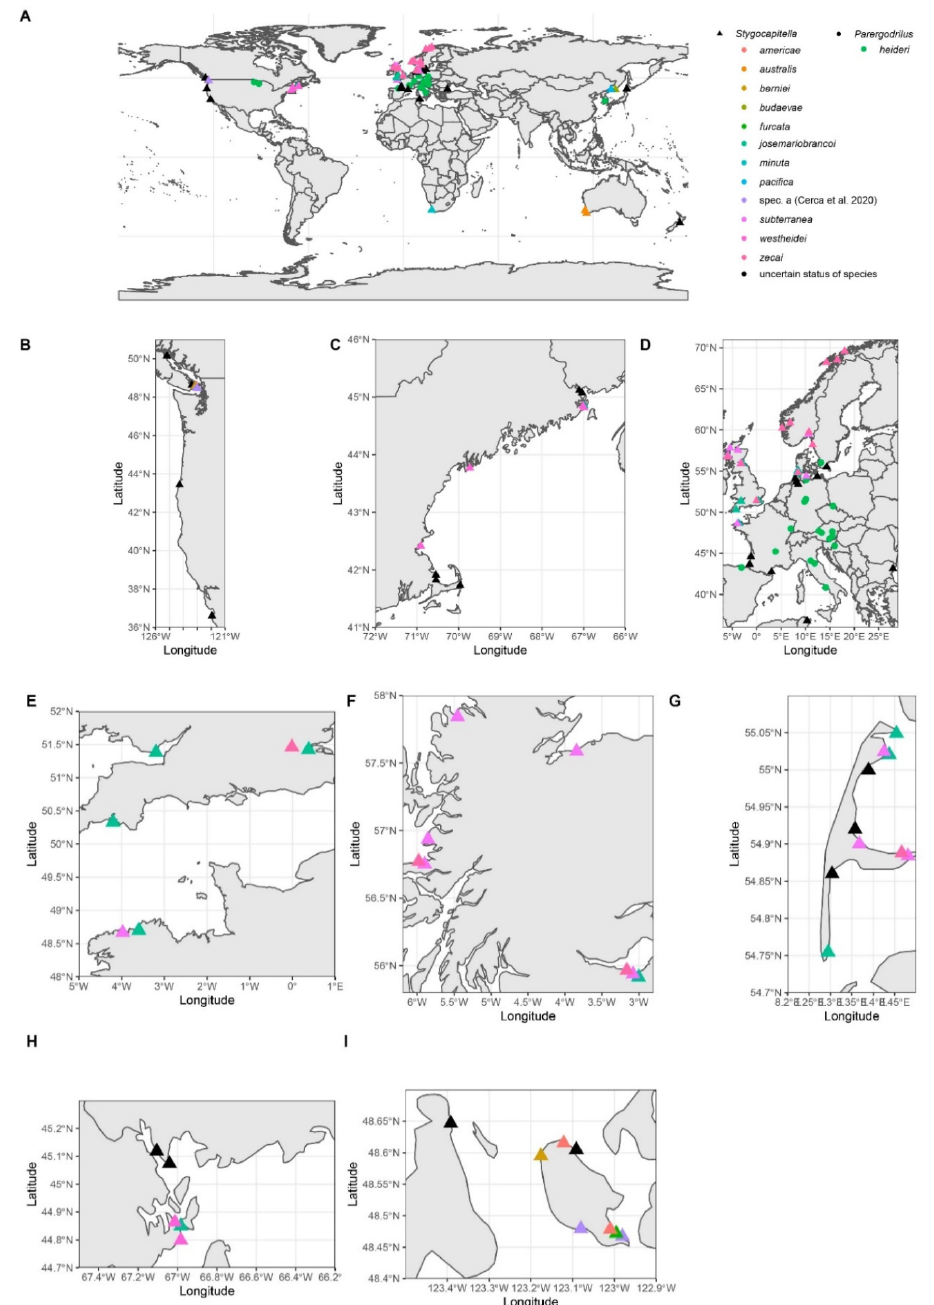
Figure 1. Map of known records for both Stygocapitella (triangles) and Parergodrilus (circles). Color codes for the different species are shown in the upper right legend. Records of Stygocapitella. with unknown species affiliation (see text) are shown as black triangles. ( A ) Whole world; ( B ) North America Pacific coast; ( C ) North America Atlantic coast; ( D ) Europe; ( E ) The Channel; ( F ) Scottish coast; ( G ) North Sea island Sylt; ( H ) Passamaquoddy Bay and adjacent waters; ( I ) San Juan Island. Maps were generated using the R packages tidyverse, ggplot2, sf, rnaturalearth, rnaturalearthdata, rnaturalearthhires, ggmap and